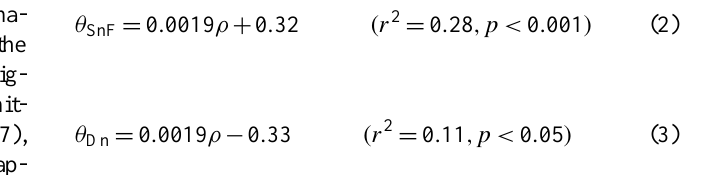
Fig. 6. Comparison of measured liquid water content using the De- noth ( θ Dn ) and the Snow Fork ( θ SnF ) instruments in (a) all wetness conditions ( n = 134) and in (b) in dry snow as a function of snow density ( ρ ). Linear regression models are shown in both plots. The median off-set of the θ SnF for the dry snow data is marked by the dark-blue dot ( ρ =250 kg m 3 , θ SnF =0.8 vol.%). plied in the contour plots (as in Fig. 5) and is described in